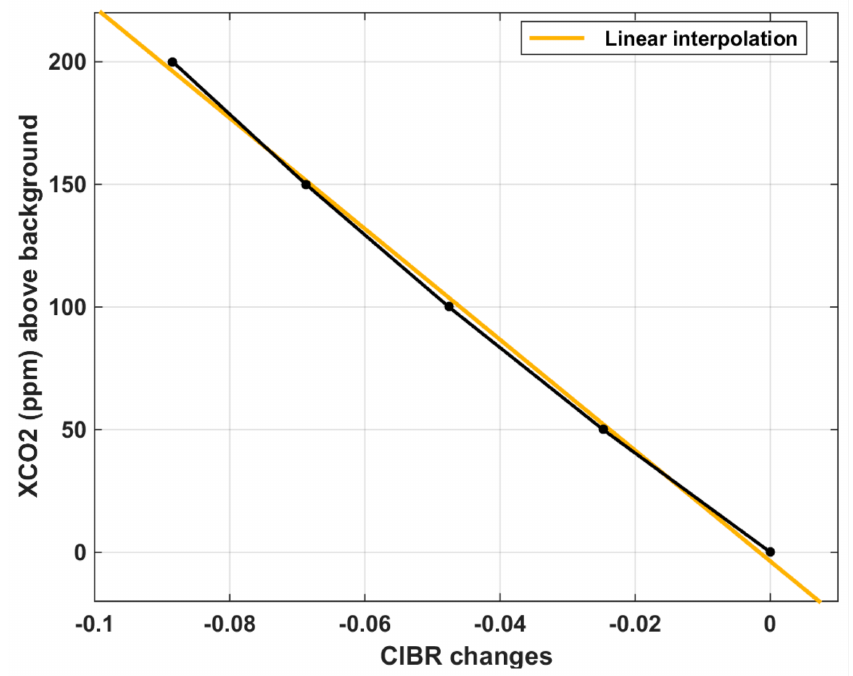
Figure 5. Modelled relationship between CIBR changes and XCO 2 enhancements.